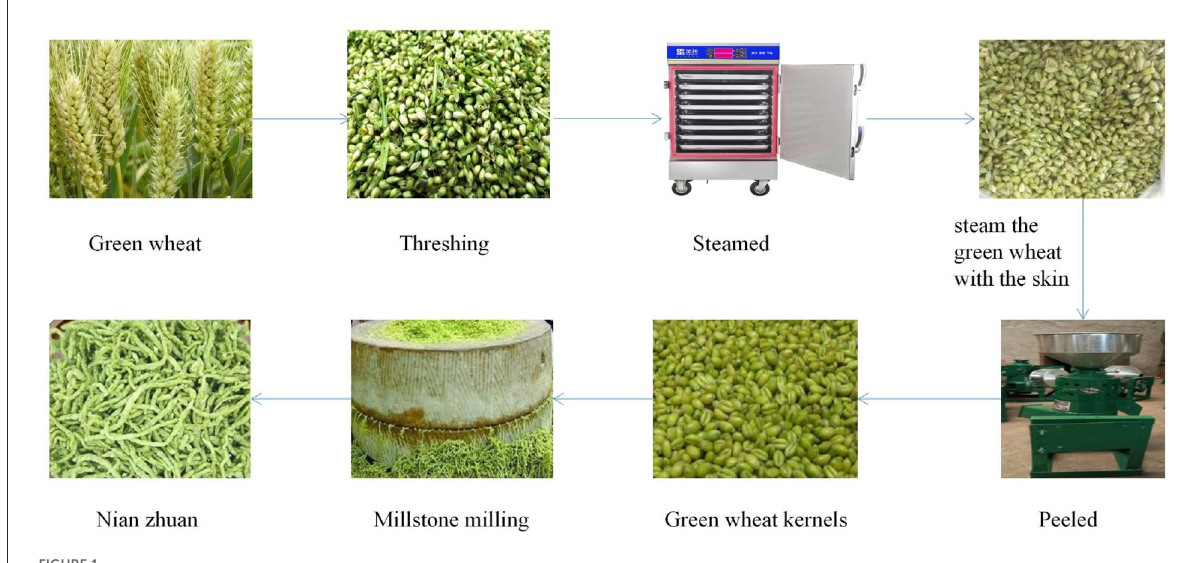
FIGURE1 Equipment and procedure used in the production of nian zhuan.